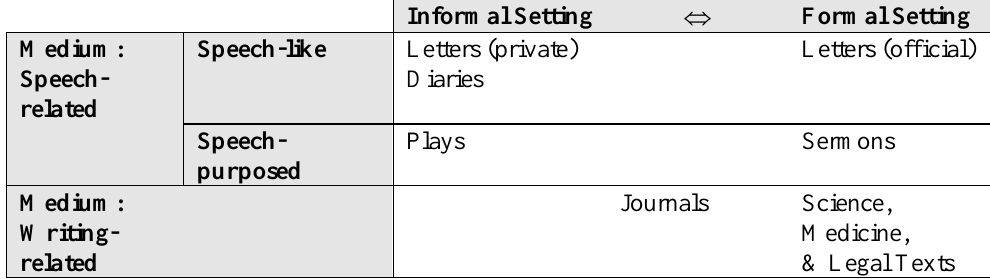
Table 1. Yáñez-Bouza’s continuum of registers